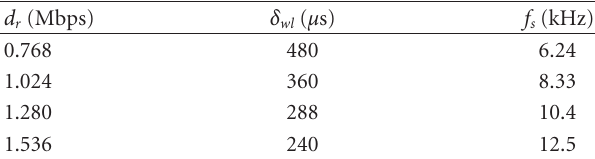
Table 2: Delay and sample frequency for di ff erent data